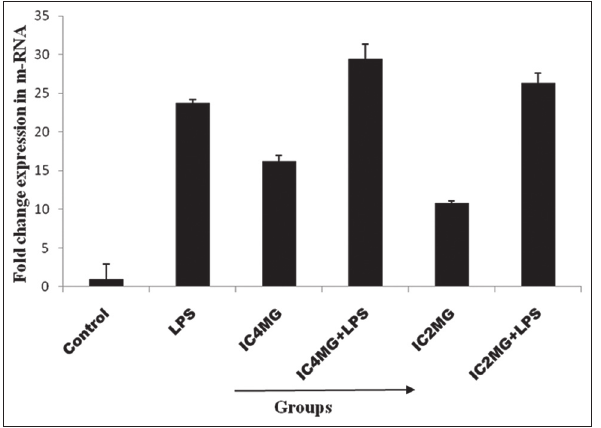
Figure-1: Fold change expression of toll-like receptor-9 mRNA following oral exposure to indoxacarb (4 and 2 mg/kg) for 90 days with and without lipopolysaccharide. Values are expressed as mean±standard error.